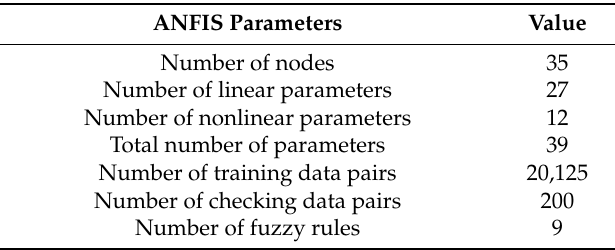
Table 1. The detailed parameters of the proposed ANFIS.